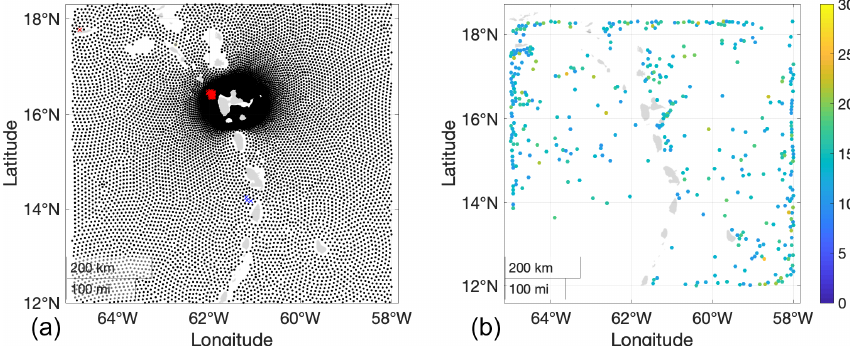
Figure 4. Diagnostics for STM-E. (a) Plot of Kendall’s τ for analysis region using a threshold of 10m. Each point corresponds to a location where SWH data are available and water depth exceeds 100m. The black dots indicate values of Kendall’s τ within the 90% confidence interval. Red (blue) crosses indicate positive (negative) values of Kendall’s τ exceeding the 90% confidence band. The percentage of recorded exceedances of the 90% confidence band for Kendall’s τ is less than 10%. (b) Locations of all STMs exceeding 10m coloured by size of STM in metres.